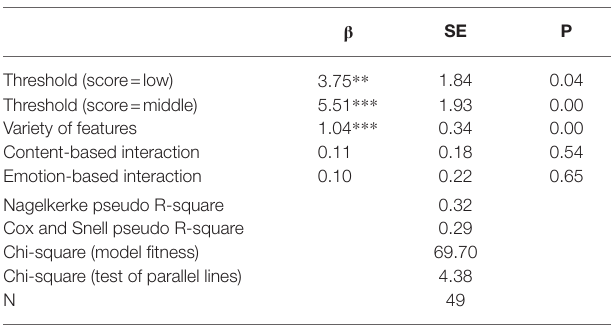
TABLE 6 | Results of OLR analysis.